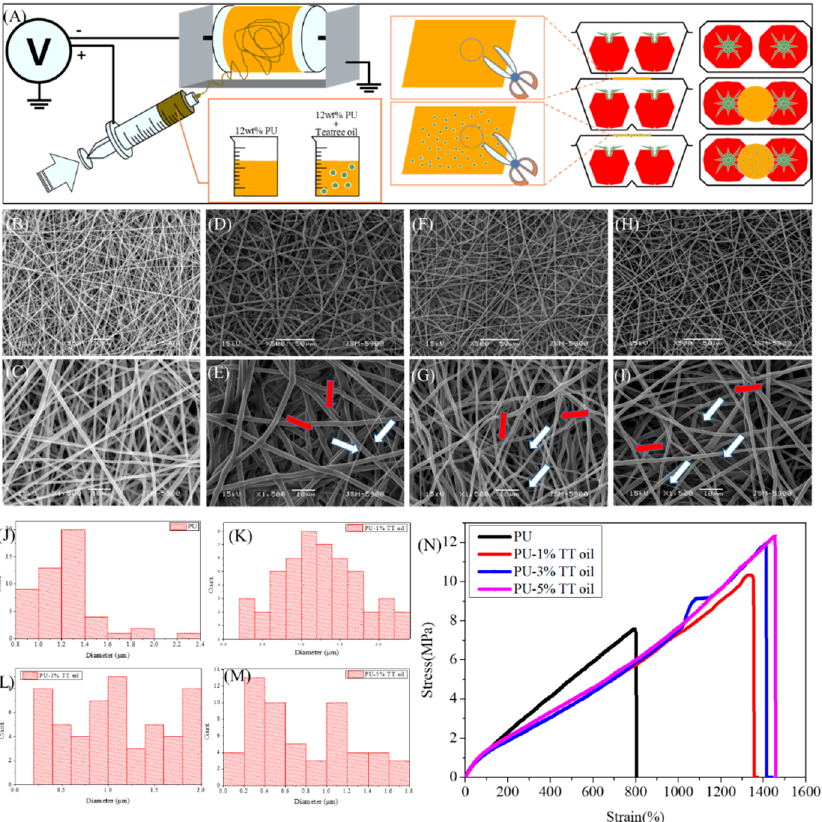
Figure 1. ( A ) The schematic of the packaging using electrospinning method. ( B – I ) SEM images in two magnitudes ( × 0.5 k (top), × 1.5 k (bottom)) of nanofibers with %1, 3% and 5% of tea tree (TT) oil (the red and white arrow indicates the nanofiber with diameter of 1 µ m and 200 nm, respectively). ( J – M ) Histogram of diameter of nanofibers with 1%, 3% and 5% of TT oil. ( N ) Stress–strain curve of nanofibers with di ff erent concentrations of TT